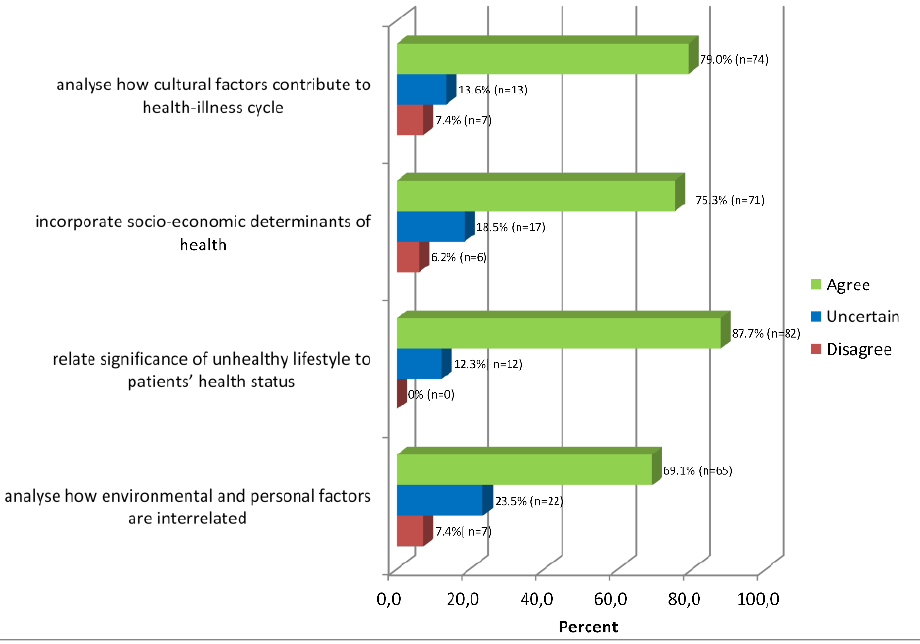
Figure 1: Ability of novice nurses to integrate other factors involved in patients’